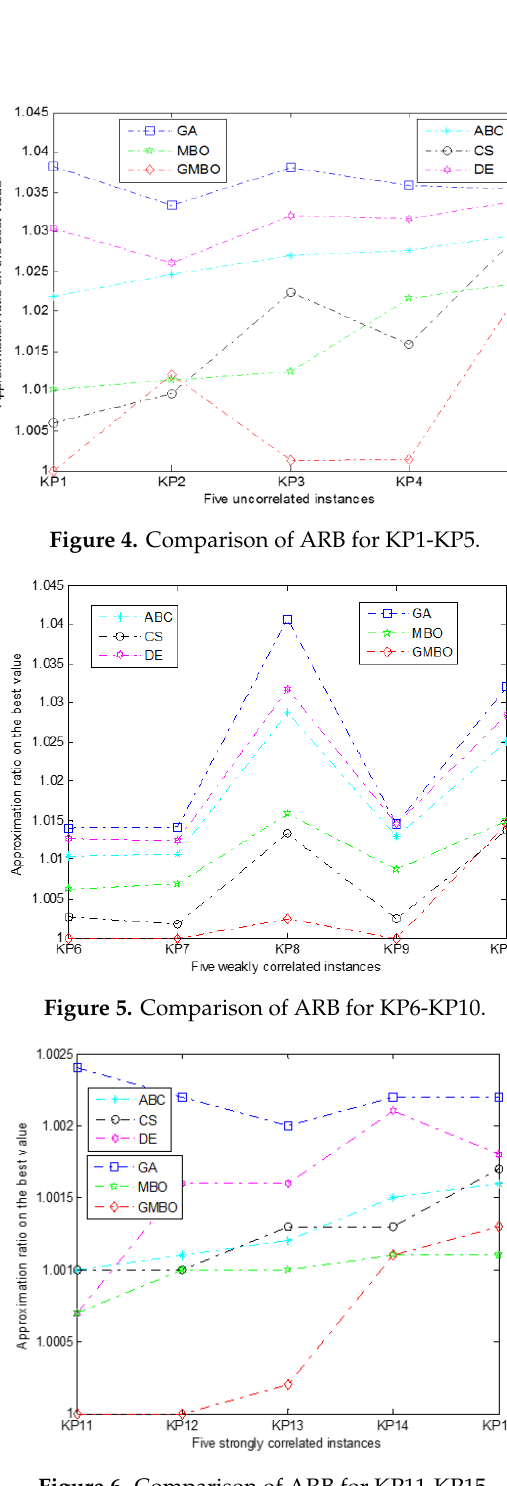
Figure 6. Comparison of ARB for KP11-KP15.